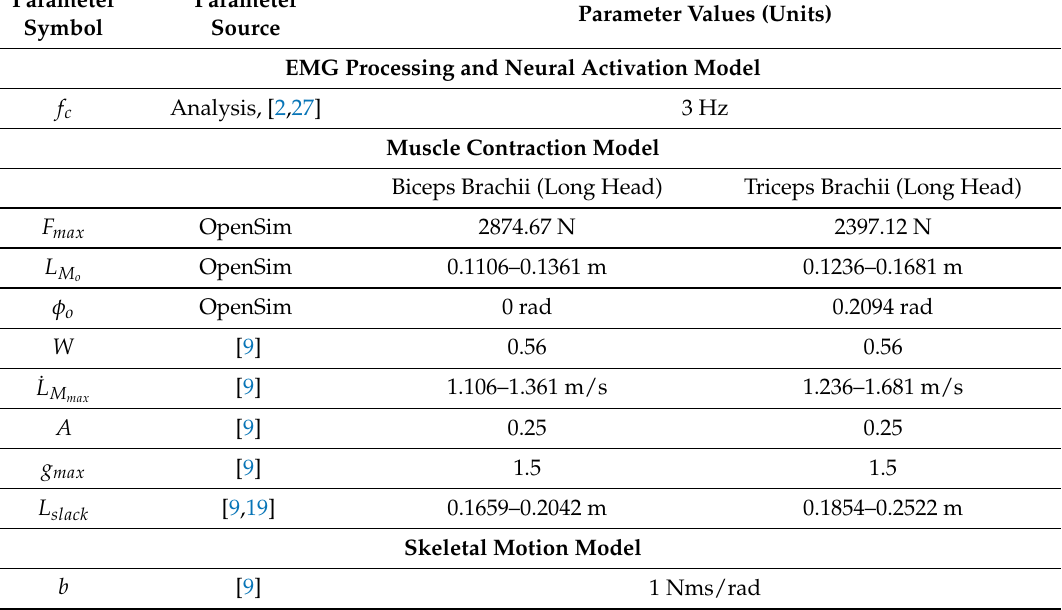
Table 2. Description and source information for elbow model